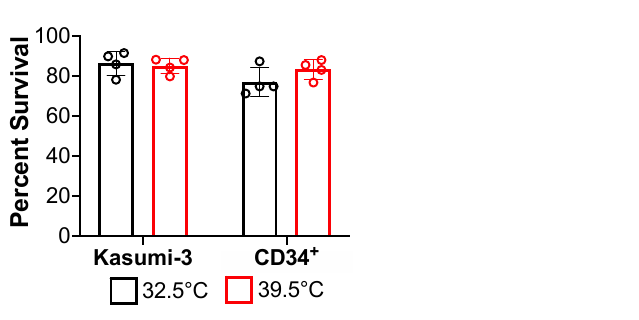
Figure 2. Kasumi-3 and CD34 + cells survive in culture at 32.5 °C and 39.5·°C. Each cell type was cultured for 7 d at the indicated temperature, and cell viability was assessed using trypan blue staining. Data are shown as percent survival relative to the original number of cells plated. Error bars indicate SD; representative data shown ( n = 3 biological replicates, each with n = 4 technical replicates).